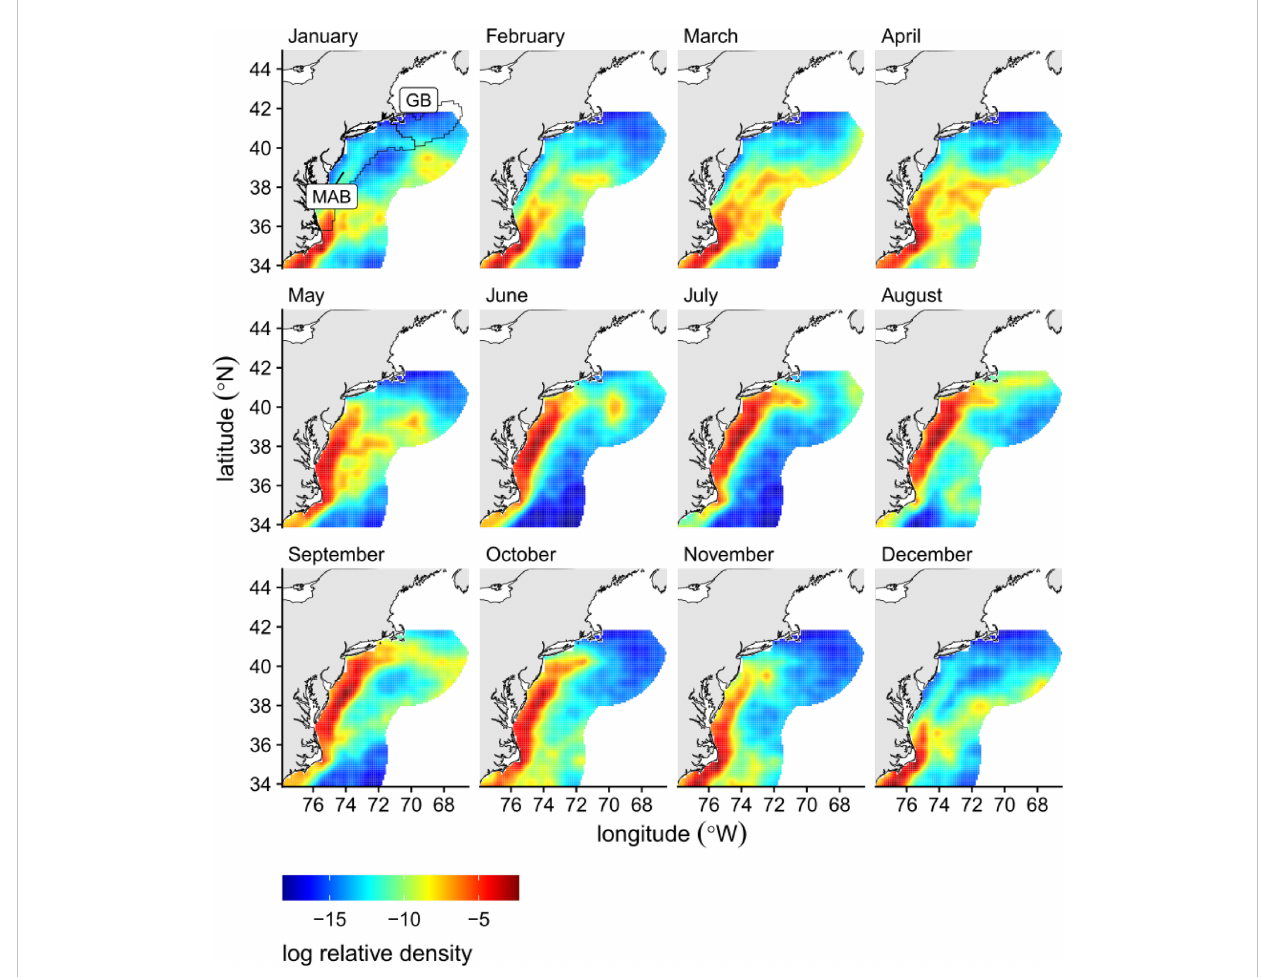
FIGURE 1 Logged relative densities of tagged loggerhead locations from 2004 – 2016 modi fi ed from Winton et al. (2018) upsampled to a 10km × 10km grid using cubic convolution. The Georges Bank (GB) and Mid-Atlantic (MAB) regions are outlined and labeled on the fi rst panel (NEFSC,